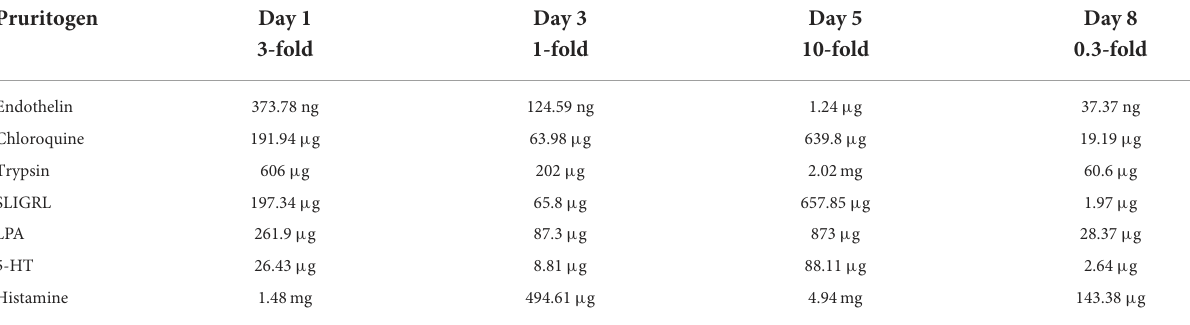
TABLE 2 Pruritogens and their respective dose and sequence of injection.